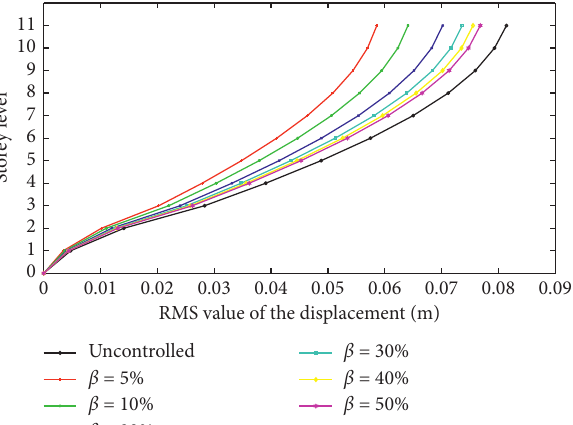
Figure 10: RMS value of the displacement of each storey of the controlled structure subjected to “ Christchurch ” acceleration record for TMDI designed with µ � 5% and the J P optimization alternative.